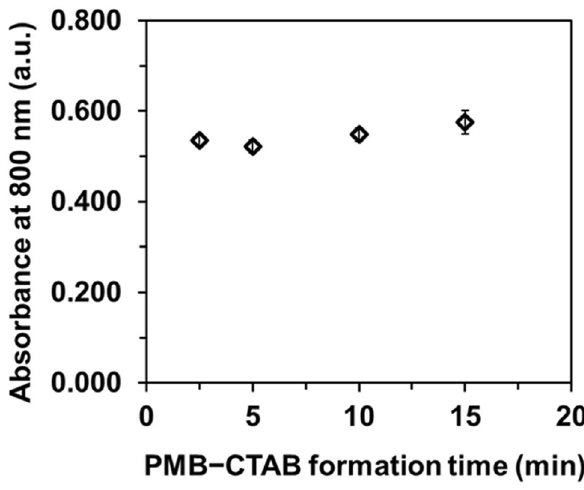
Figure 4. Investigation of PMB–CTAB formation time at room temperature before d-MSPE. Absorbance ± SD, n = 3.